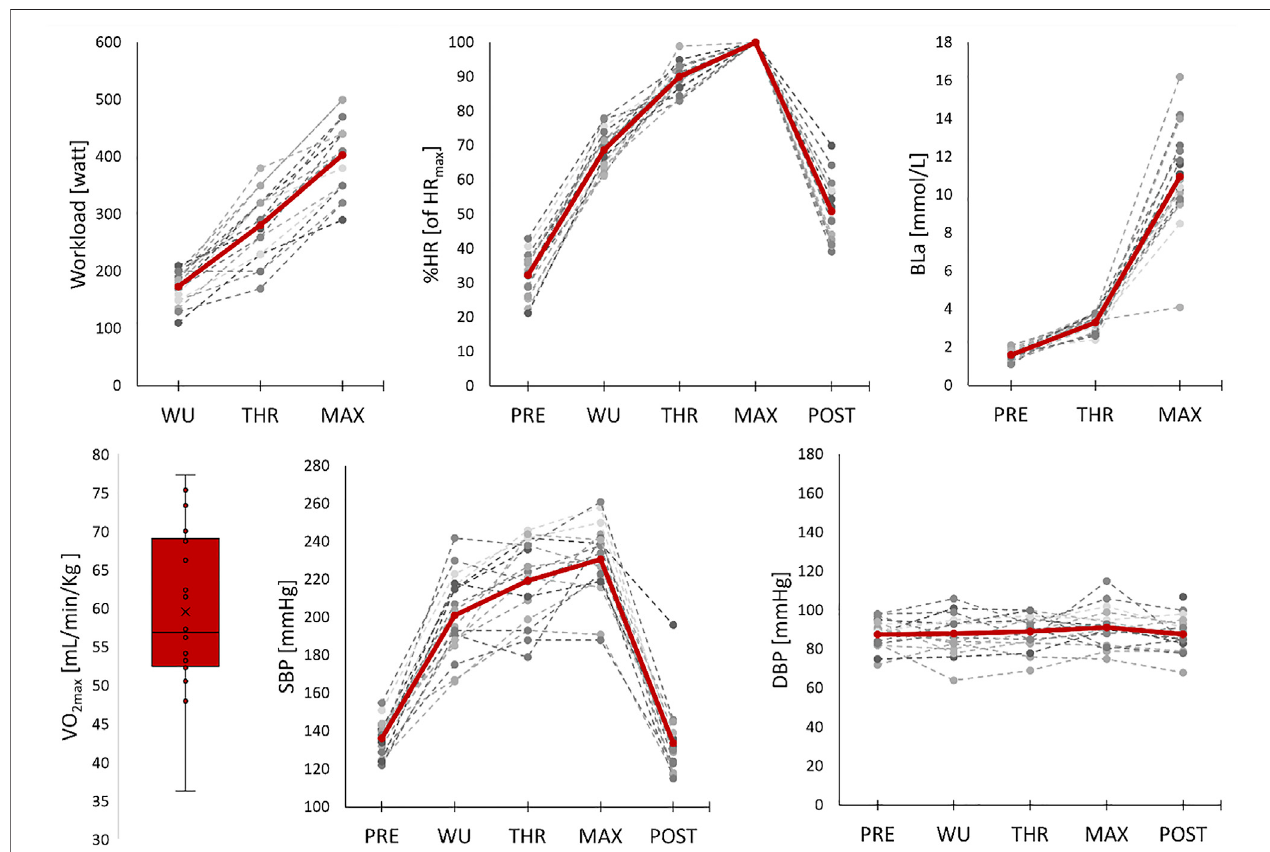
FIGURE 2 | VO 2max is presented as a box and whisker plot with median, interquartile range, and minimum and maximum value, otherwise Individual (dotted lines) and mean (red line) values for workload, percentage of maximal heart rate (%HR), blood lactate (BLa), systolic blood pressure (SBP) and diastolic blood pressure (DBP) during the protocol. PRE = values at rest before the cycling, WU = values during warm-up, THR = values at the threshold, MAX = values at maximal intensity (except for BLa which was measured directly after the maximal intensity), POST = values measured 10 min after the test.